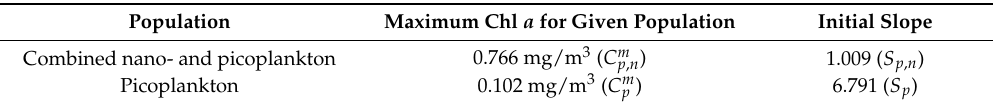
Table 2. Mean parameter values obtained for three-component method from the dataset used in this